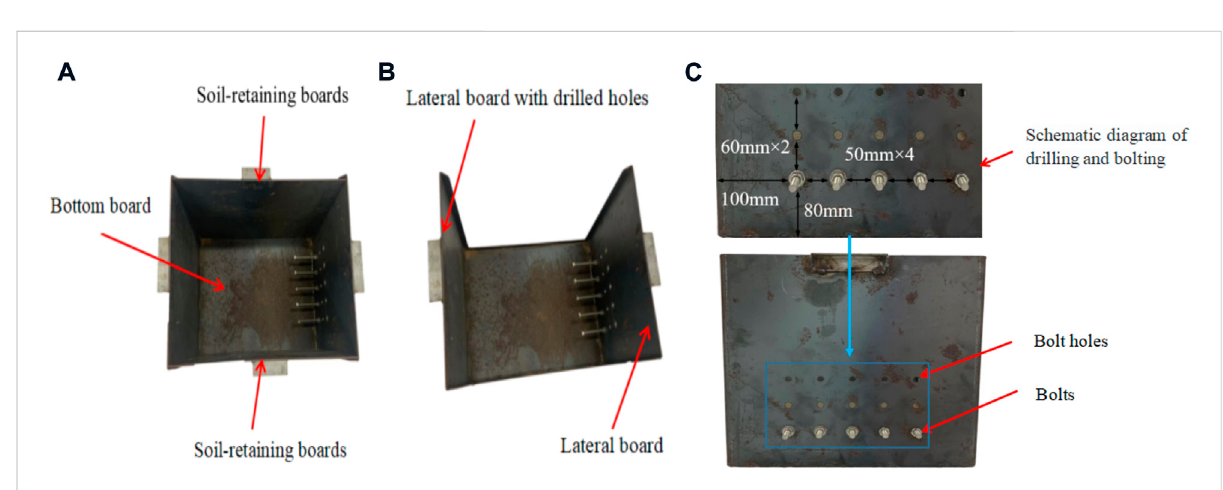
FIGURE 3 Soil box: (A) bottom board and soil-retaining boards; (B) lateral boards; and (C) locations of drilling and bolting (bolt holes and